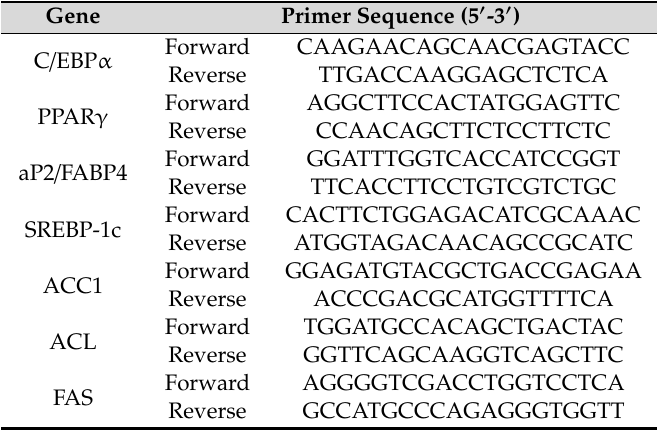
Table 1. Primers for the RT-PCR analysis. Gene Primer Sequence (5 (cid:48) -3 (cid:48)